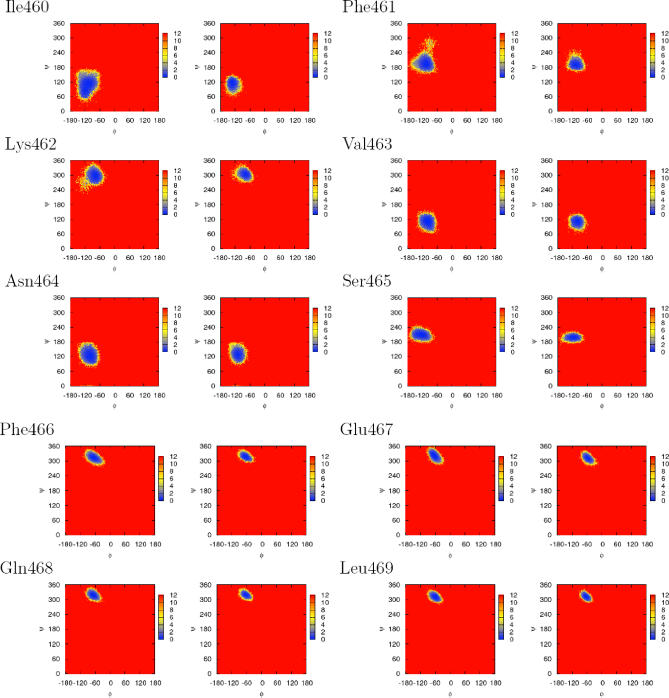
Same as Figure 4, but for Residues within the Loop between Switch II and the N-Terminal of the Relay HelixFor each residue, the map on the left is for the 1FMW:ATP state and the map on the right is for the 1VOM:ATP state.